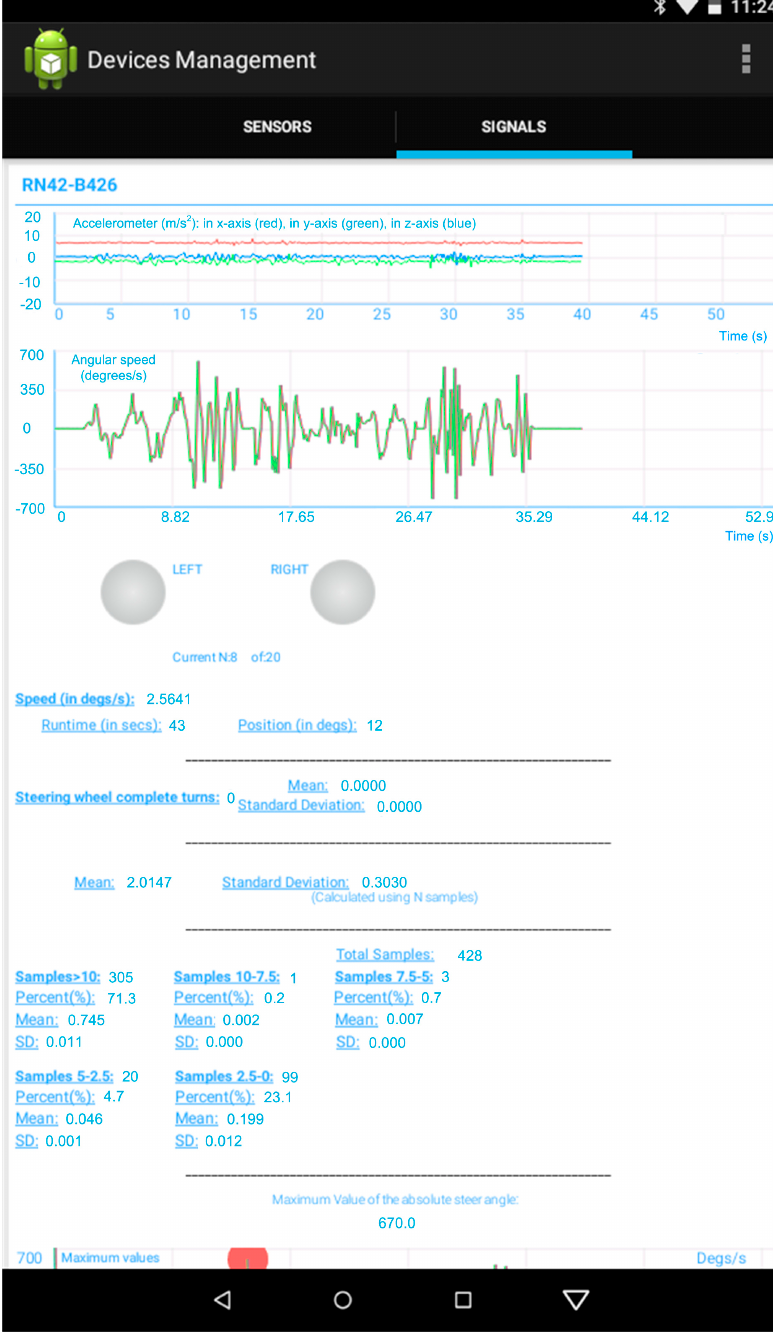
Figure 5. Graphs with the data extracted by the Nine Degreees of Freedom (9DOF) module and calculations made by the app. calculations made by the